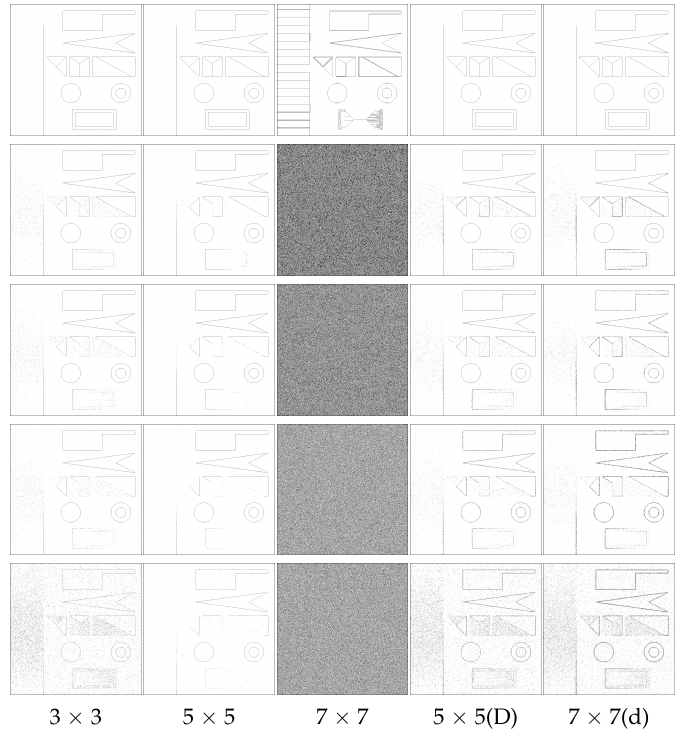
Figure 12. Visual results at different levels of noise (PSNR) for one image. Rows represent: original; 16 dB; 14 dB; 12 dB; 10